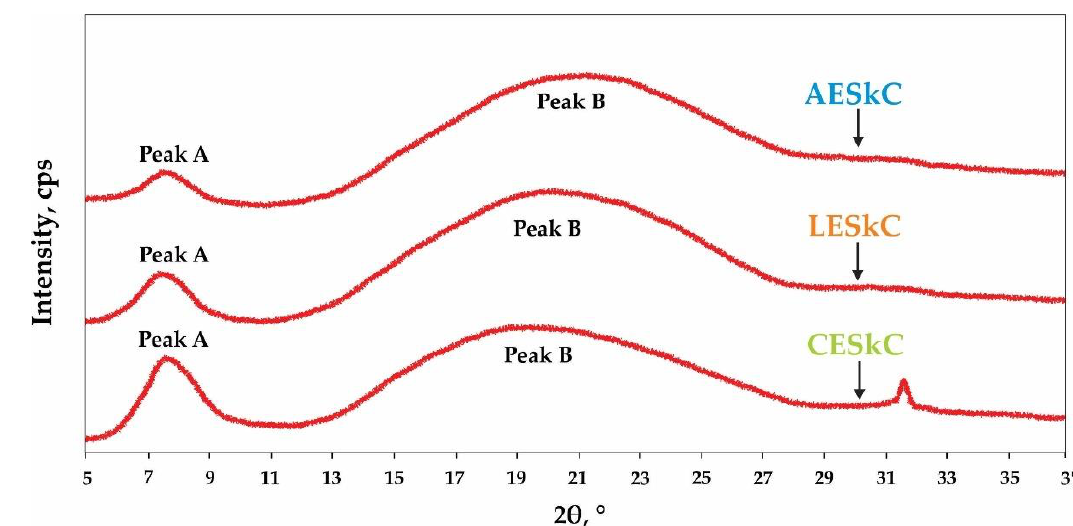
Figure 4. X-ray diffraction diagram of lizardfish skin collagens extracted with different acids. AESkC: acetic acid-extracted collagen; LESkC: lactic acid-extracted collagen; CESkC: citric acid-extracted collagen.